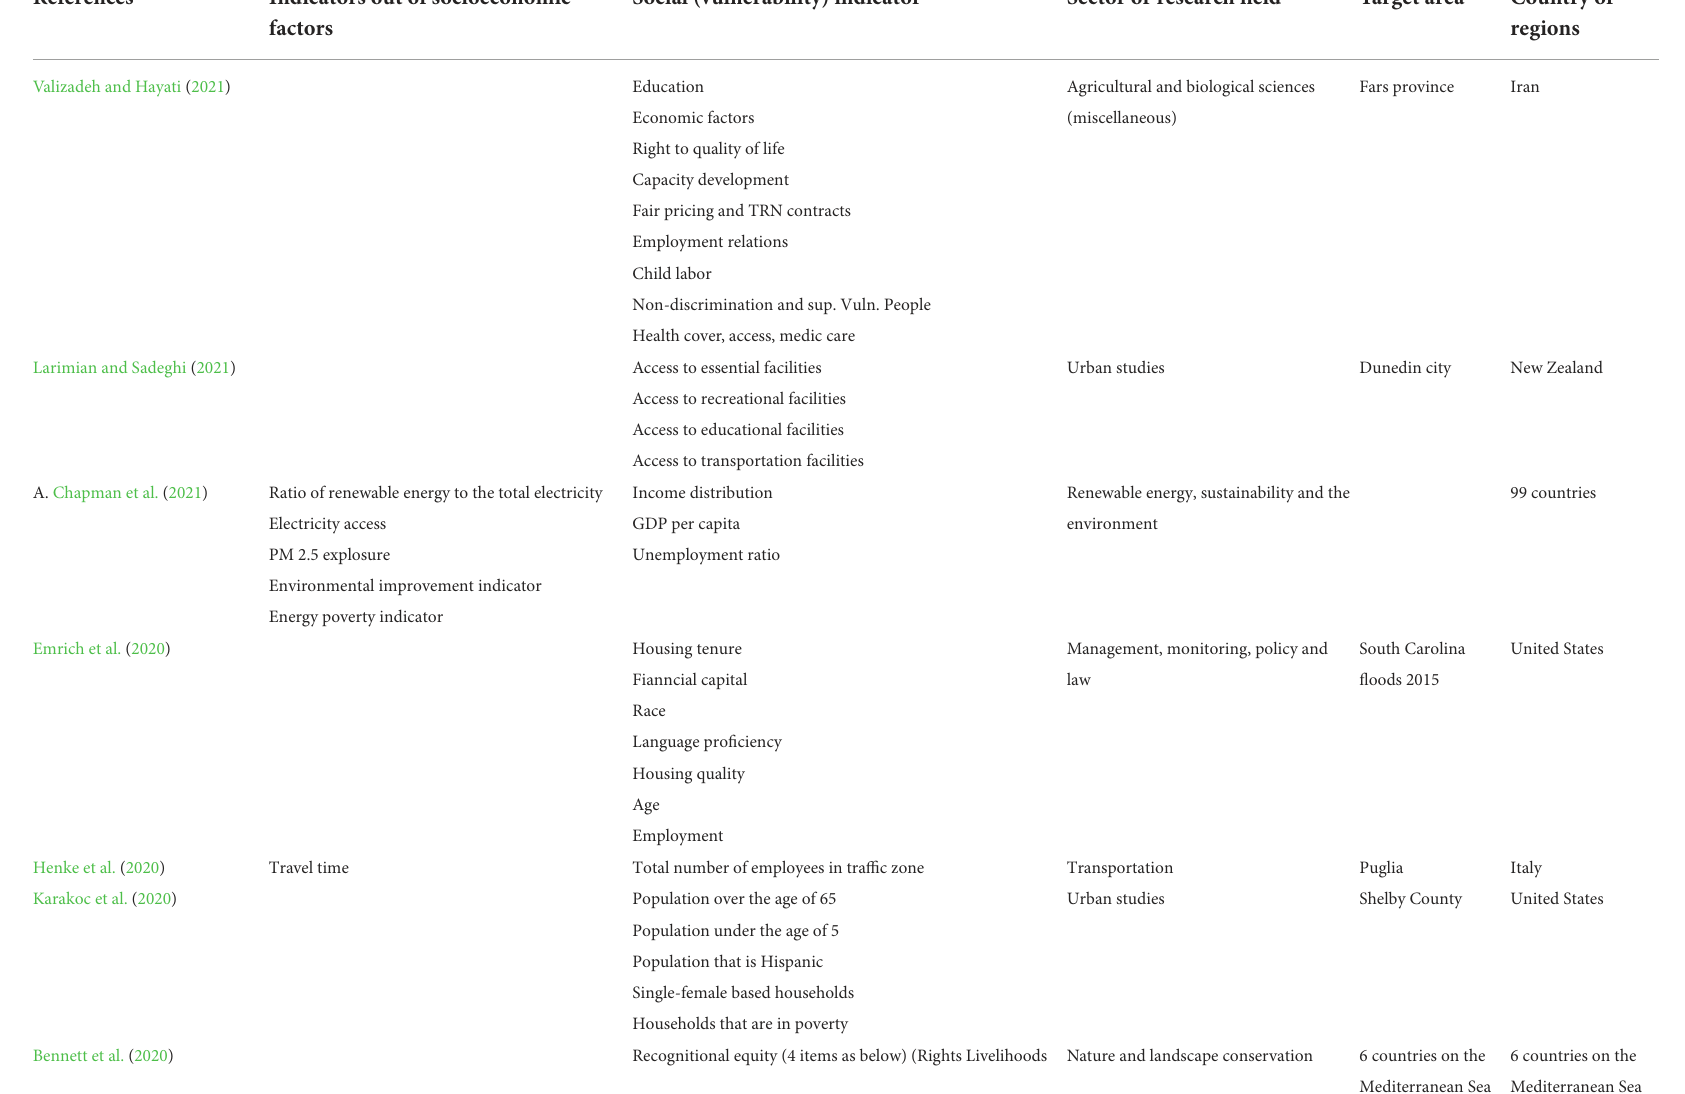
TABLE 4 List of quantitative studies of social